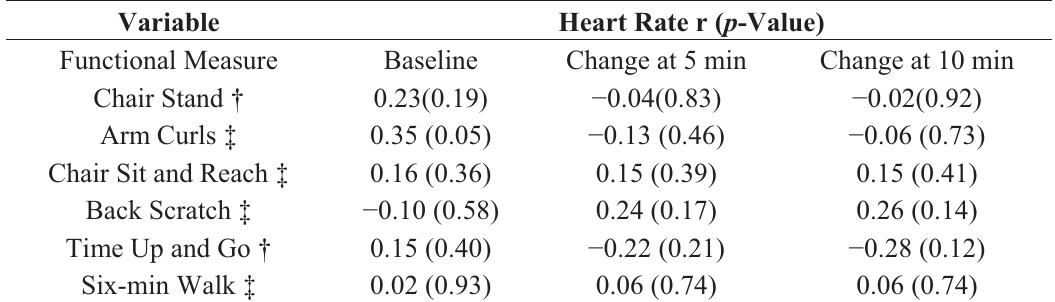
Table 5. Correlations of functional fitness measures with heart rate at baseline and change after 5 and 10 min of SCD, N =